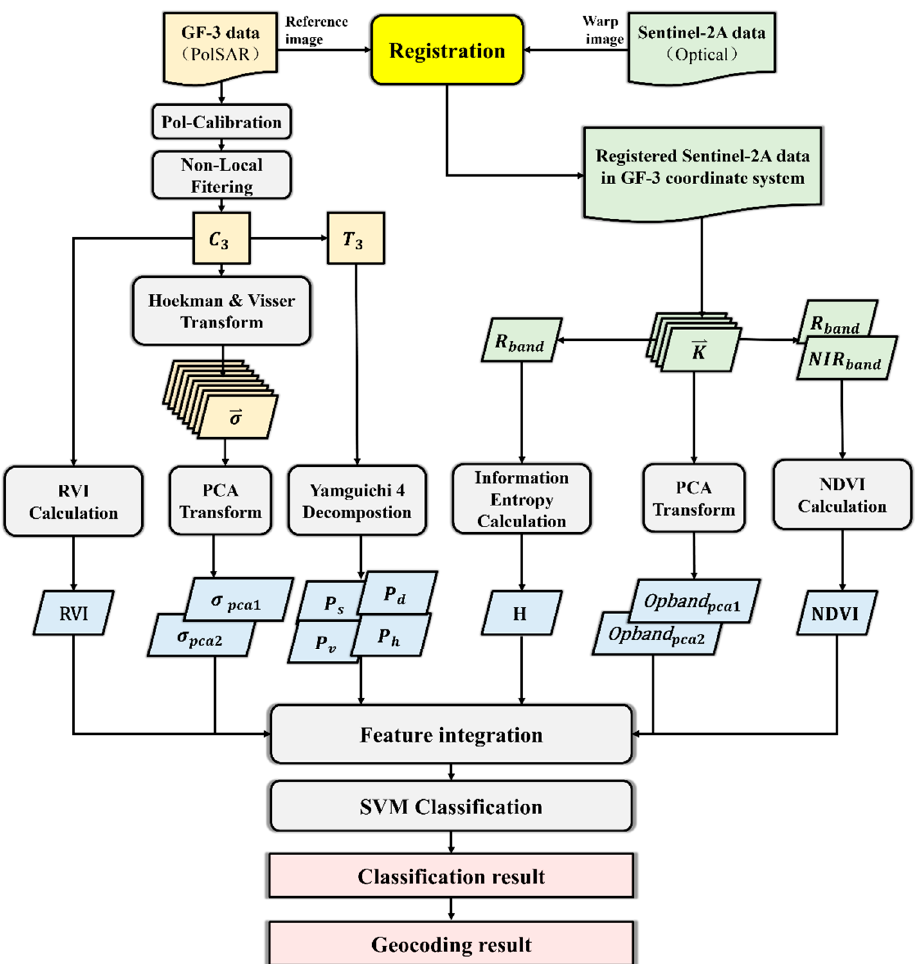
Figure 3. The flowchart of the proposed method.